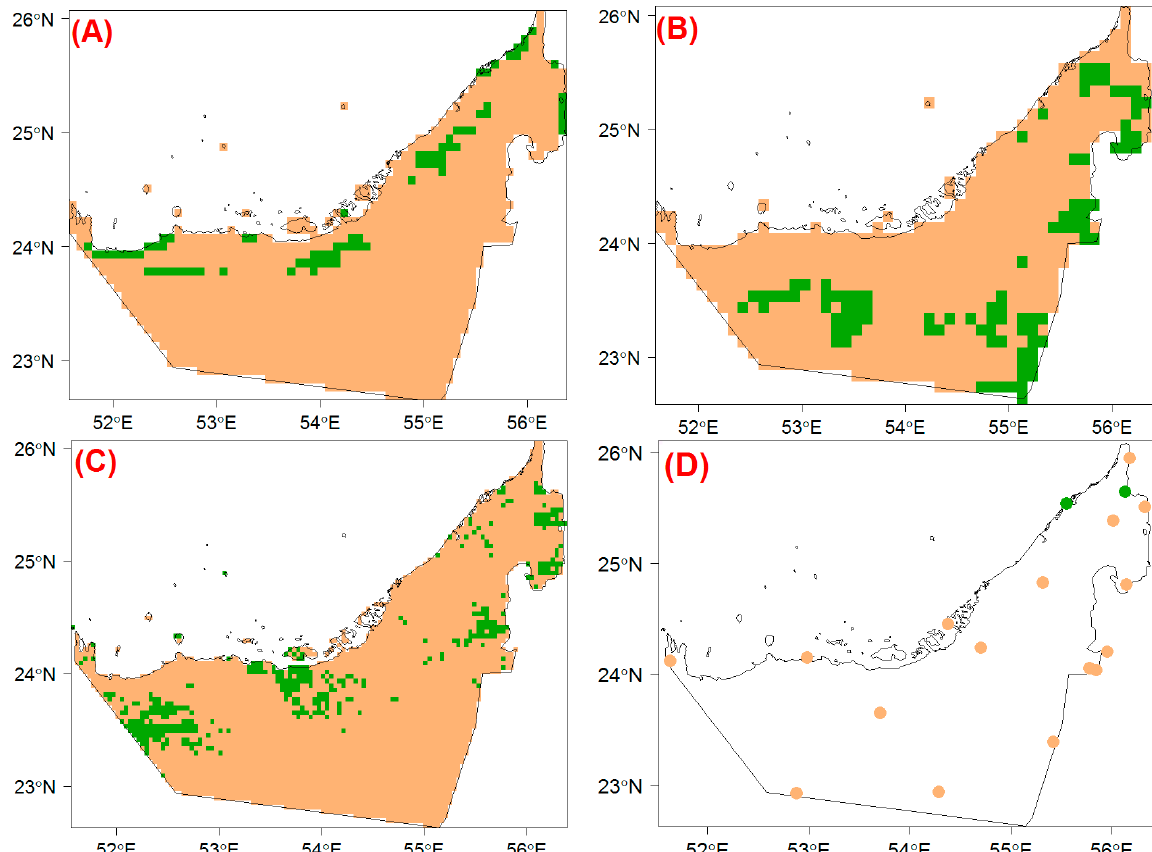
Figure 9. Locations with significant (green color) and not-significant (brown color) rainfall change-points using Pettitt’s test for ( A ) CMORPH, ( B ) IMERG, ( C ) PERSIANN, and ( D ) rain gauges.